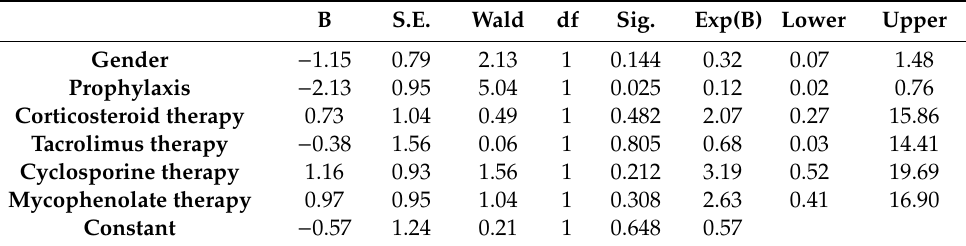
Table 3. Logistic regression for CDR